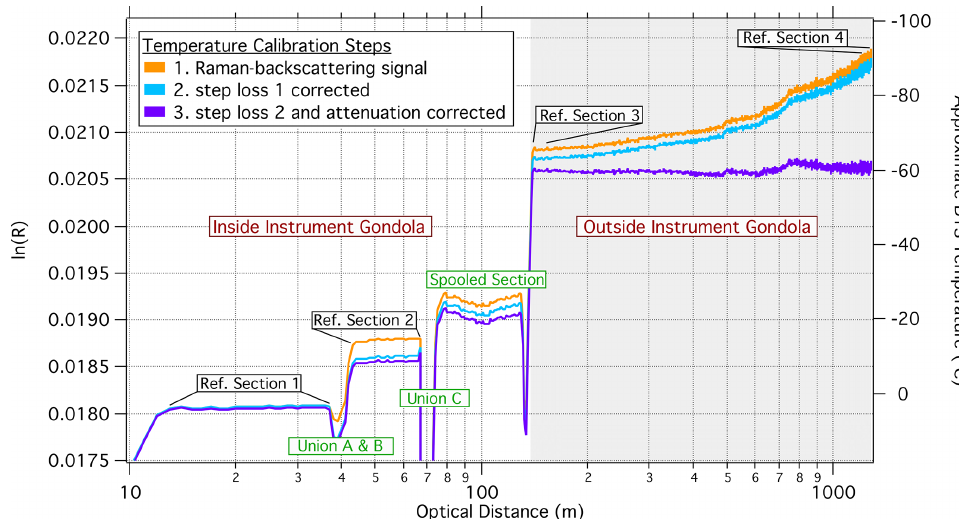
Figure A1. Raman-backscattering ratio (left axis) and approximate DTS temperature (right axis) versus optical distance of FLOATS from an example profile with the full deployment of 1167m of fiber. The raw backscattering signal (orange trace), step loss 1 corrected (blue trace), and optimized backscattering signal (purple trace) are shown. Locations of the uniform temperature reference sections are depicted with black boxes. Insertion loss and unsolvable sections are highlighted with green boxes.